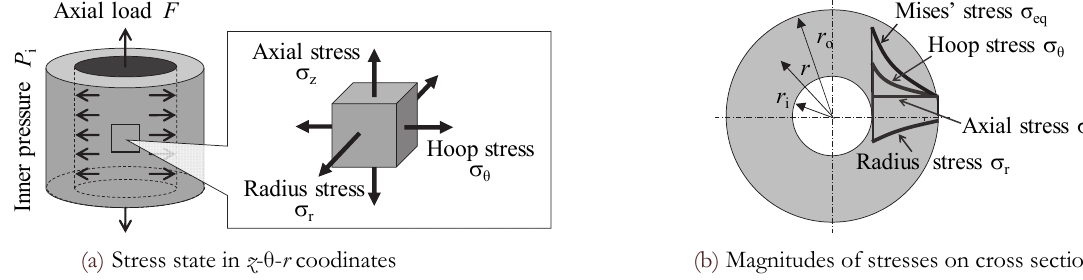
Figure 4: Directions and values of the principal stresses in the thickness direction of the specimen.